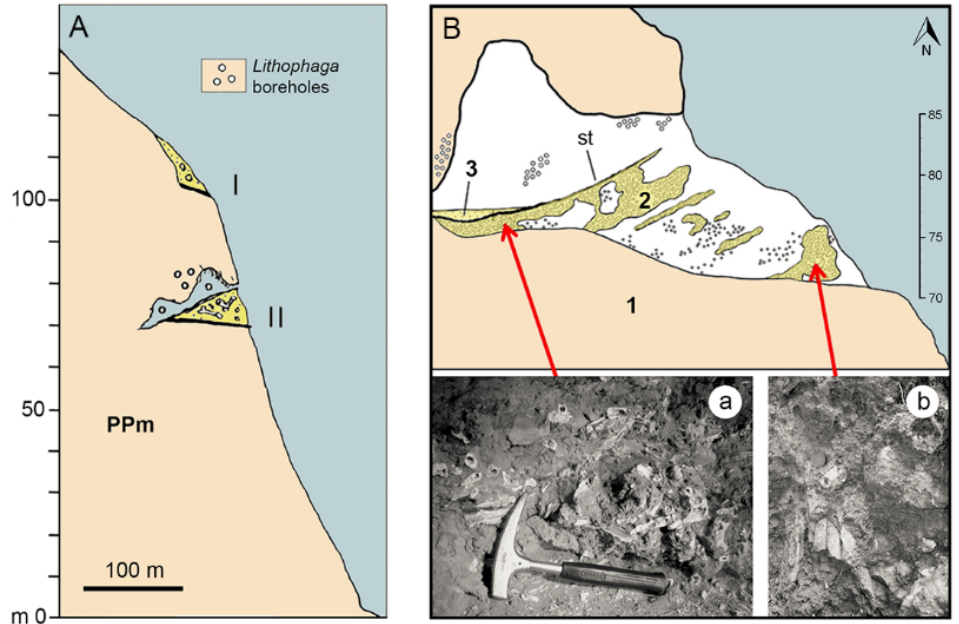
Figure 11. ( A ) Schematic profile of the Tindari steep cliff showing a marine abrasion platform at 104 m (I) and below the MIS5.e abrasion platform and coastline at 90–60 m (II) underlying the mammal-bearing deposit of the Donnavilla Cave. PPm: Proterozoic and Palaeozoic marbles. ( B ) Stratigraphic sequence of the eastern wall of the cave. 1: Substrate; 2: bone breccia with fossil bones in its upper-most sandy-silty brown portion ( a ) and cranial remains of Hippopotamus pentlandi ( b ); 3: very fine sands filling a channel and overlying the speleothem; st: dated stalagmite; circles: Lithophaga holes (from Ref. [40], modified).